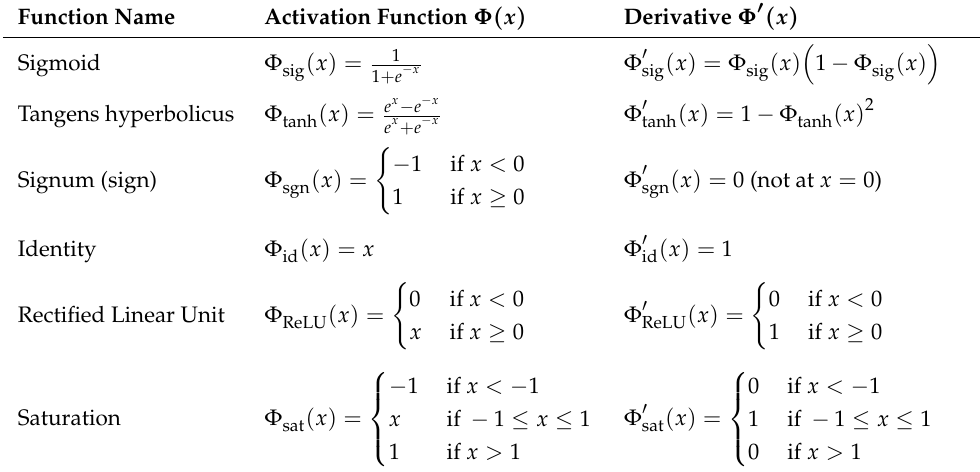
Table 1. Mathematical definitions of different activation functions and their